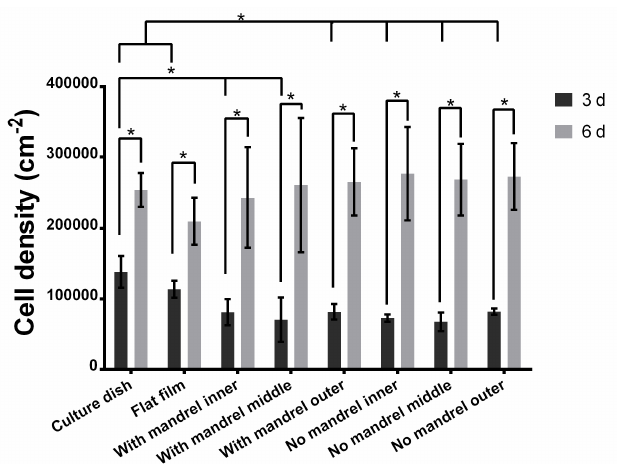
Figure 5. Cell proliferation at 3 and 6 days with or without mandrel. All tests were biological triplicates. * indicates a p value smaller than 0.05.